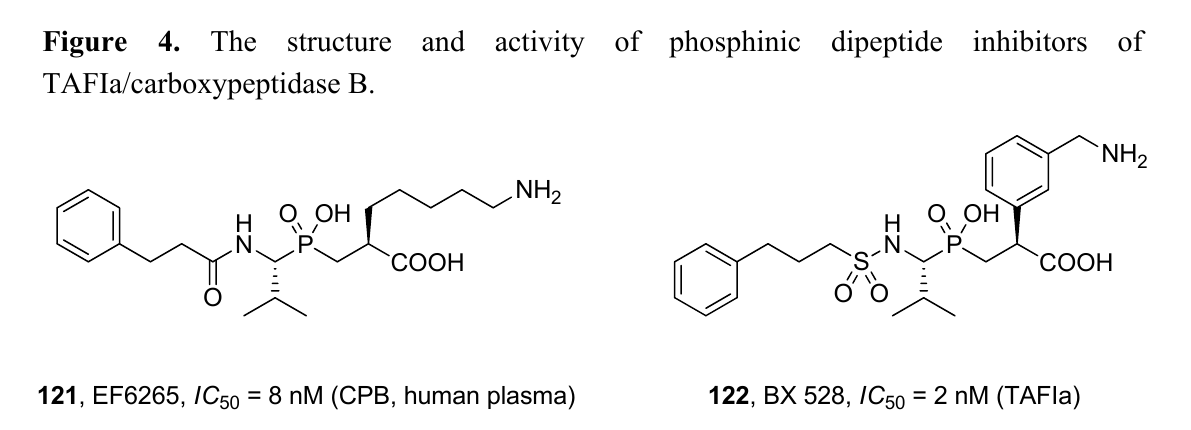
NH 2 POHO H N COOH O = 8 nM (CPB, human plasma) 50